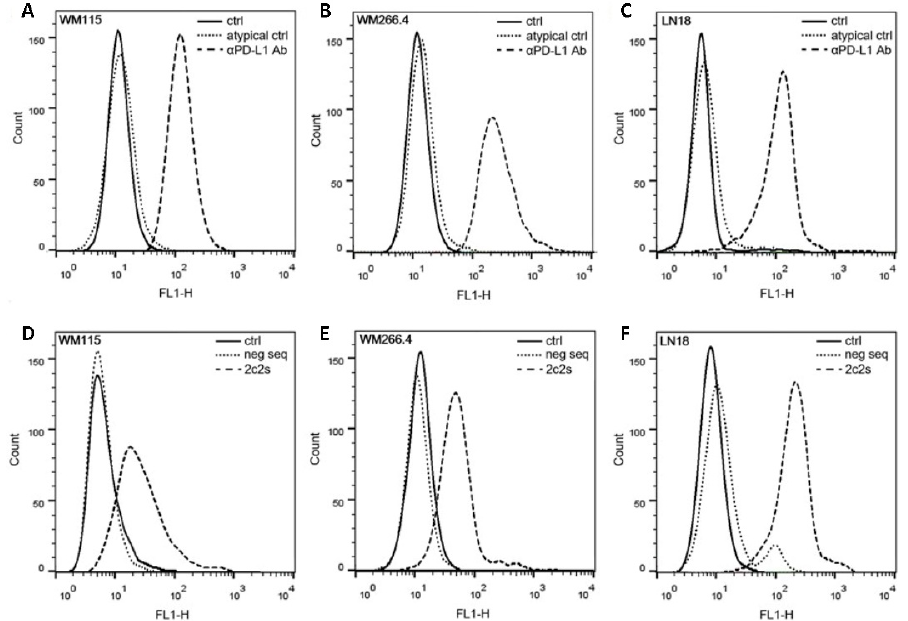
Figure 6. Detection of PD-L1 expression at the surface of representative melanoma cell lines by flow cytometry. ( A , D ) WM115, ( B , E ) WM266.4 and ( C , F ) LN18. Top panels—mAb staining (50 nM); bottom panels—2c2s staining (50 nM). Isotype antibody and scrambled sequence aptamer were used as respective